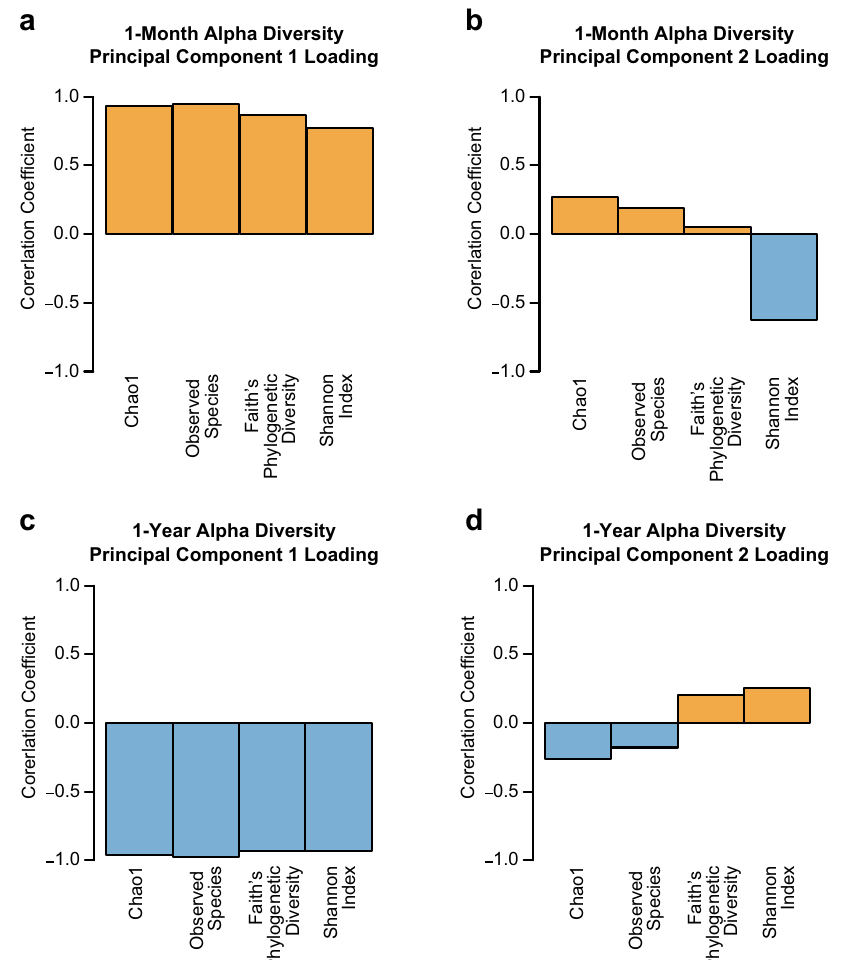
Fig. 1 Loading of individual alpha diversity metrics on principal components. a , b Loading of Chao1, Observed Species, Faith ’ s Phylogenetic Diversity, and Shannon Index on alpha diversity principal component 1 and 2 at 1 month of age. c , d Loading of Chao1, Observed Species, Faith ’ s Phylogenetic Diversity, Shannon Index on alpha diversity principal component 1 and 2 at 1 year of age. Source data for this fi gure are provided as a Source Data fi